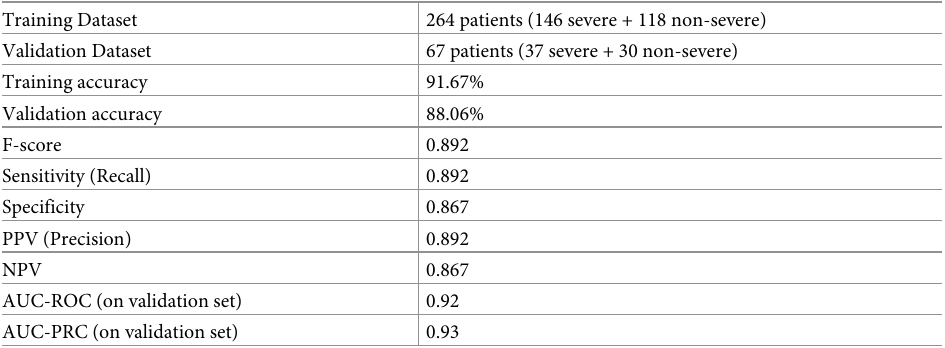
Table 2. Performance of severity prediction